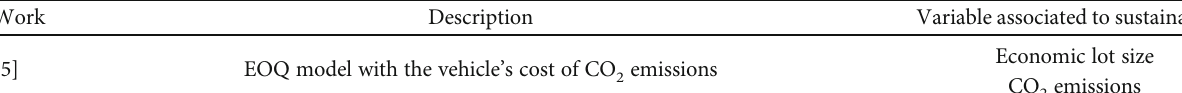
Table 1: Review of works on inventory control with sustainable aspects (own